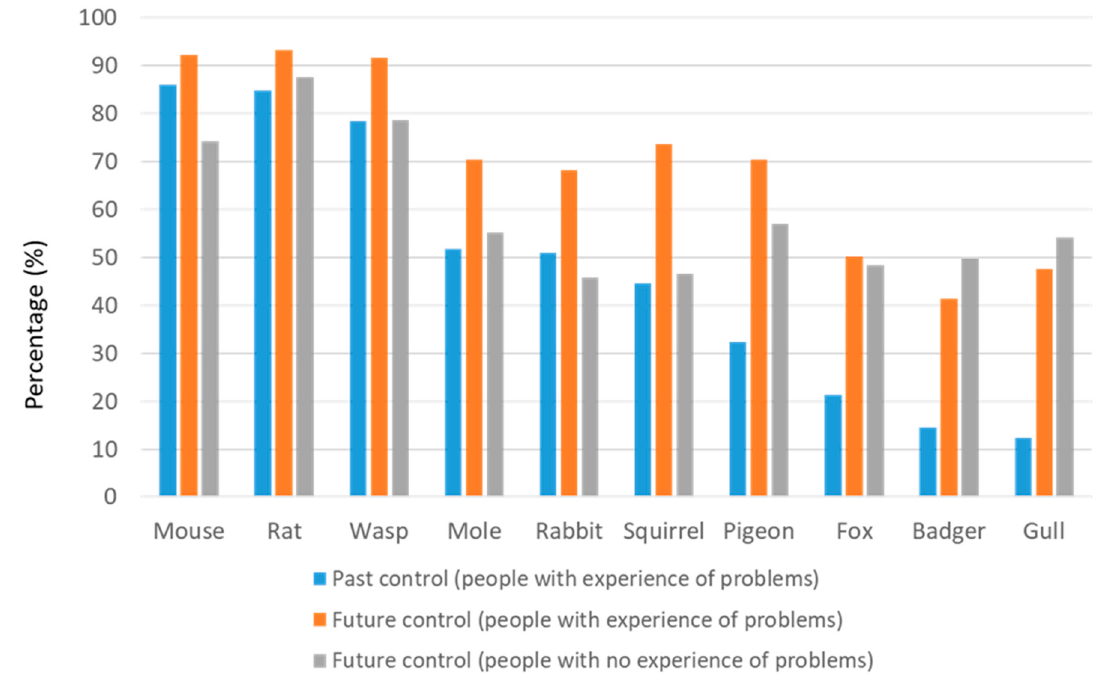
Figure 4. Reported past control and predicted future control rates for 10 species. Past control and predicted future control for people with experience of problems with a species ( n values for numbers with experience of a problem: mouse = 622, rat = 438, wasp = 688, mole = 118, rabbit = 47, squirrel = 132, pigeon = 185, fox = 177, badger = 41, gull = 120) and predicted future control for people with no experience of problems ( n values for people with no experience of a problem: mouse = 1378, rat = 1562, wasp = 1312, mole = 1882, rabbit = 1953, squirrel = 1868, pigeon = 1815, fox = 1823, badger = 1959, gull = 1880).